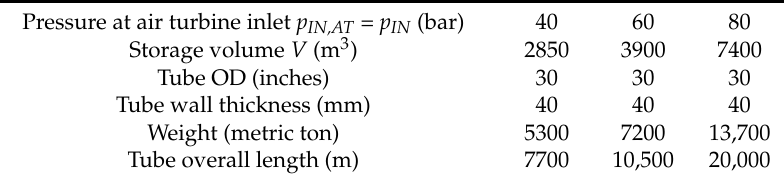
Table 3. Artificial storage tank sizing results ( p ST = 100